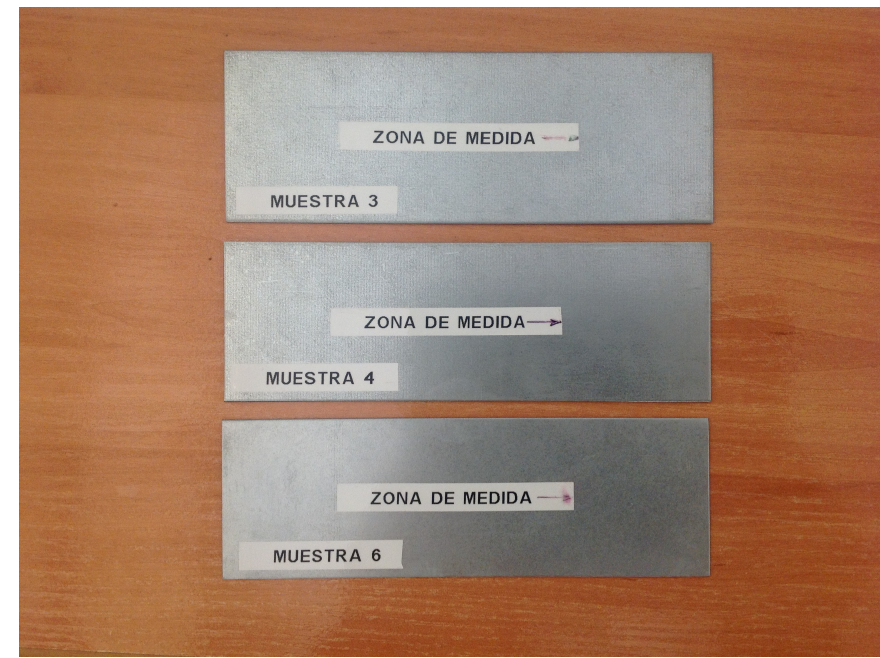
Figure 5. Examples of the steel plates used for testing.